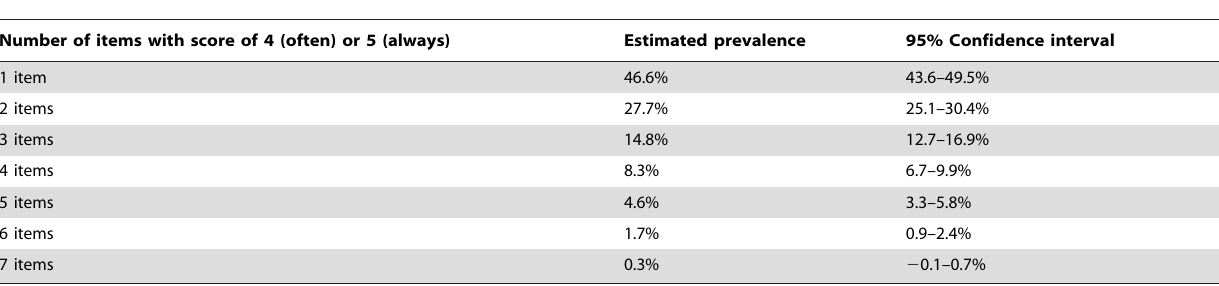
Table 2. Sensitivity for different cut-offs based on the Bergen Work Addiction Scale (N =1,108).